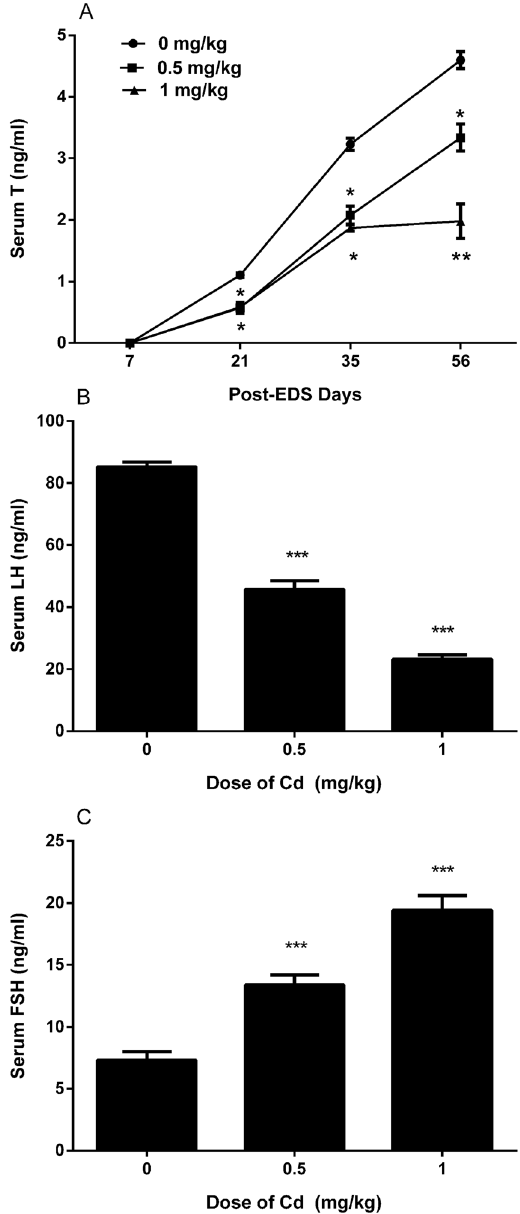
Figure 1. The levels of serum testosterone (T) on days 7, 21, 35, and 56 as well as serum LH and FSH levels on day 56 after EDS treatment with or without cadmium administration. Panel A, testosterone; Panel B, LH; and Panel C, FSH. Mean ± SE, n = 5. * P < 0.05, ** P < 0.01, and *** P < 0.001 indicate significant differences when compared to control (0 mg/kg) at each time